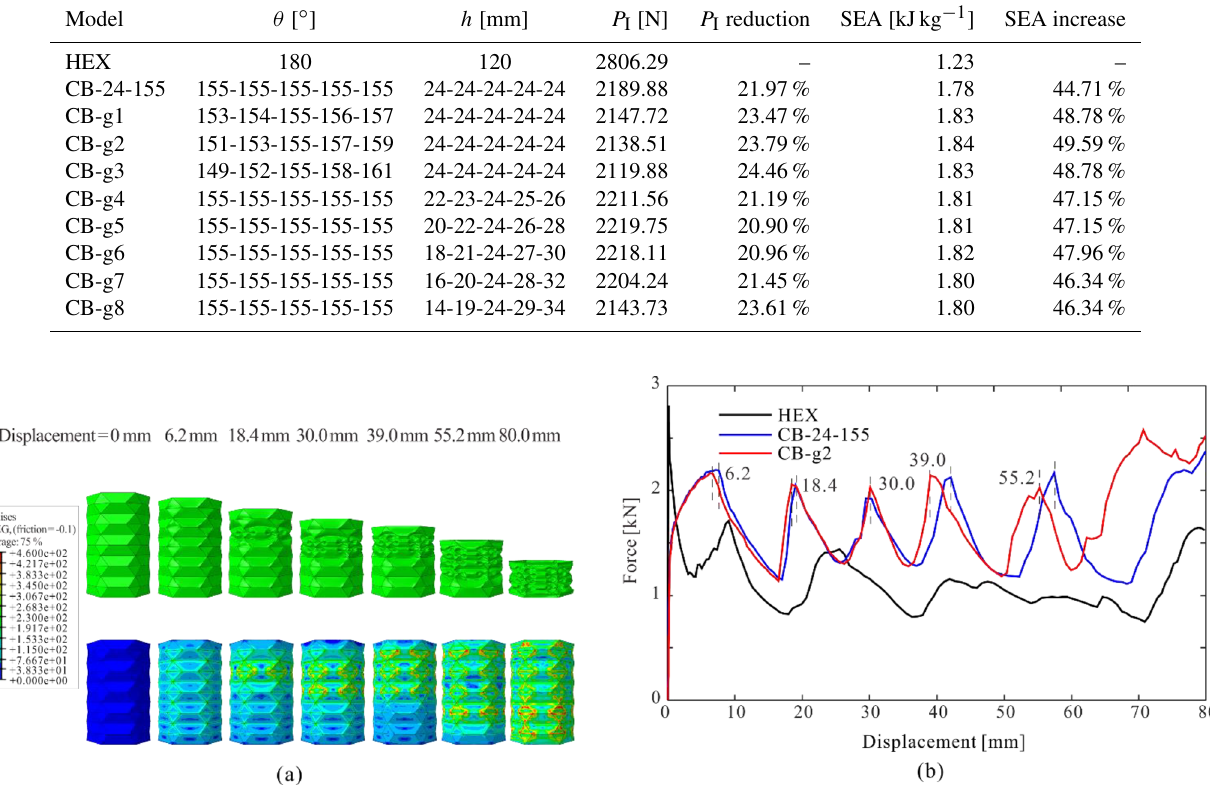
Figure 6. Effect of graded pre-folding angles. (a) The deformation process of CB-g2; (b) force versus displacement curves of HEX, CB-24- 155, and